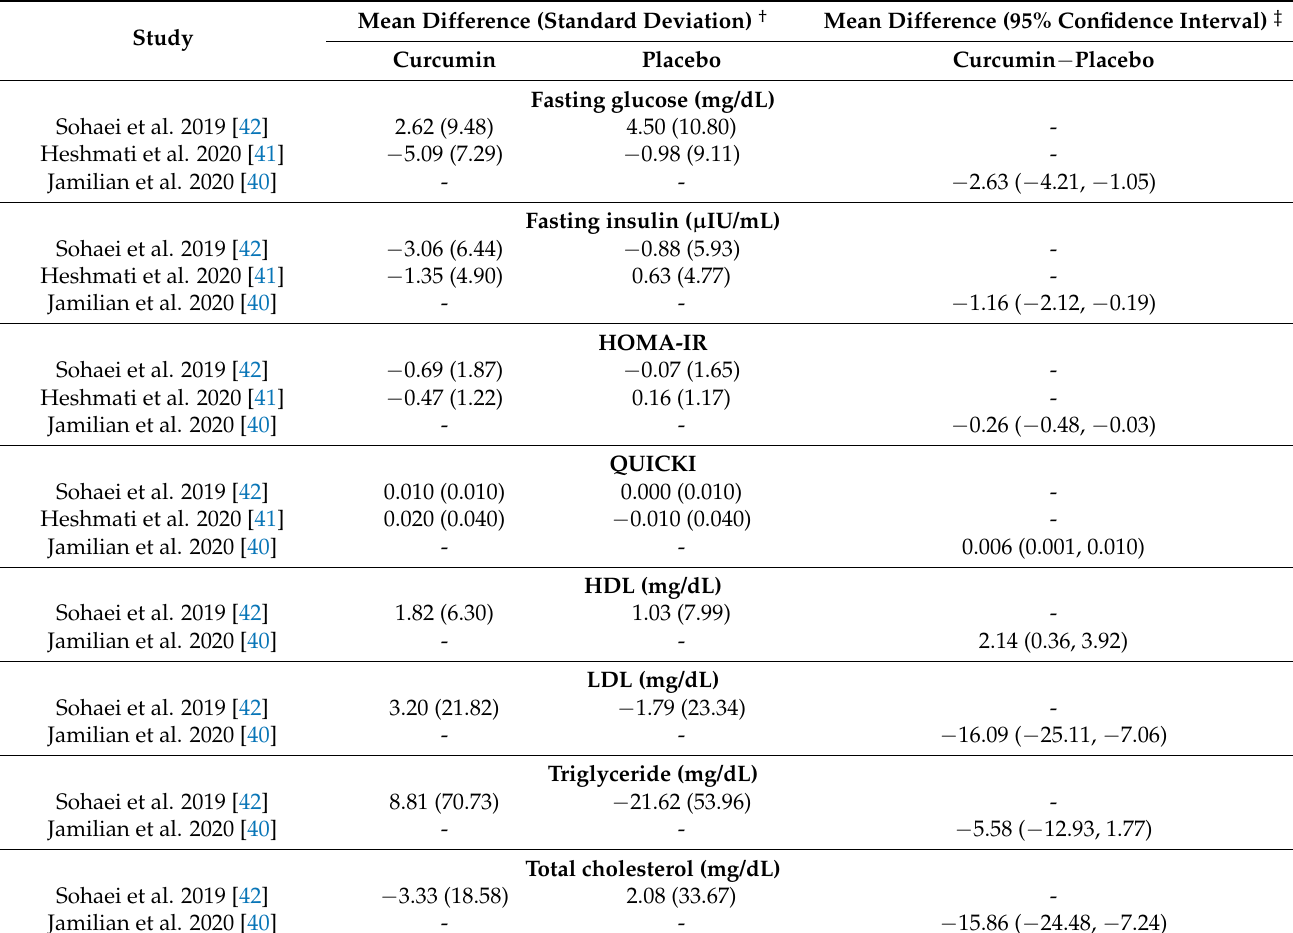
Table 2. Measurement of glycemic control and lipid profile in the curcumin and placebo